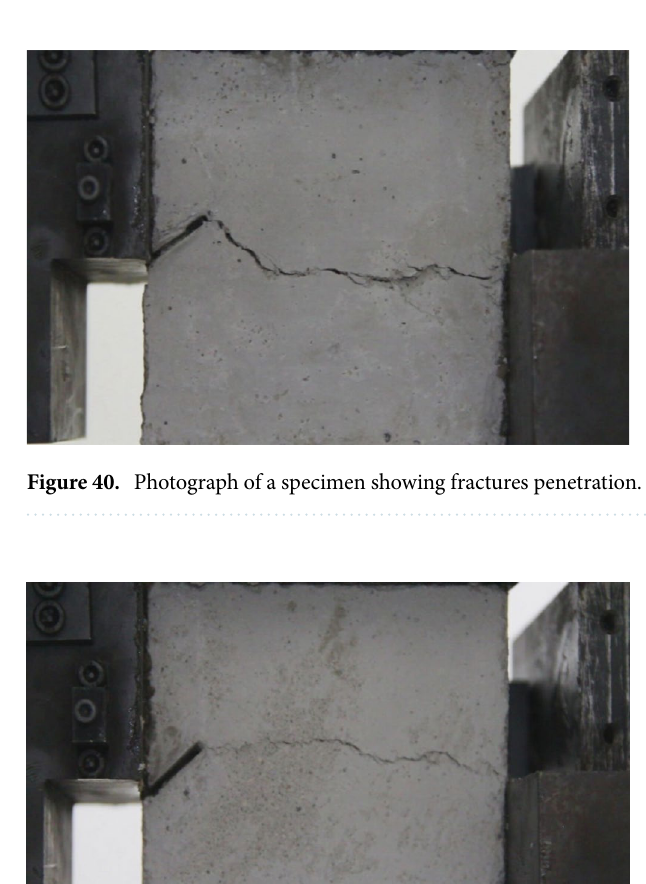
Figure 39. Photograph of a specimen showing fractures appearing.